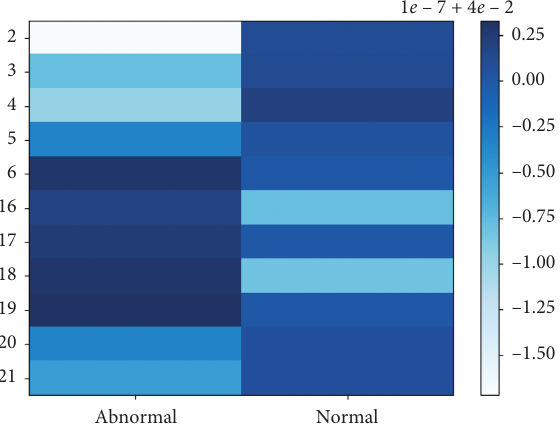
Figure 5: Heat map about correlation between variables. The number of the chromaticity bar is the chromaticity value, not the correlation between the